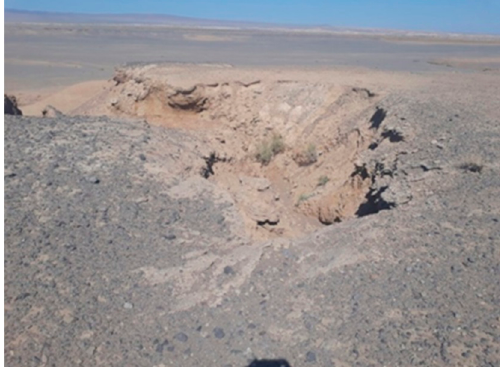
Figure 3. Sample of mapped gullies in the study area.